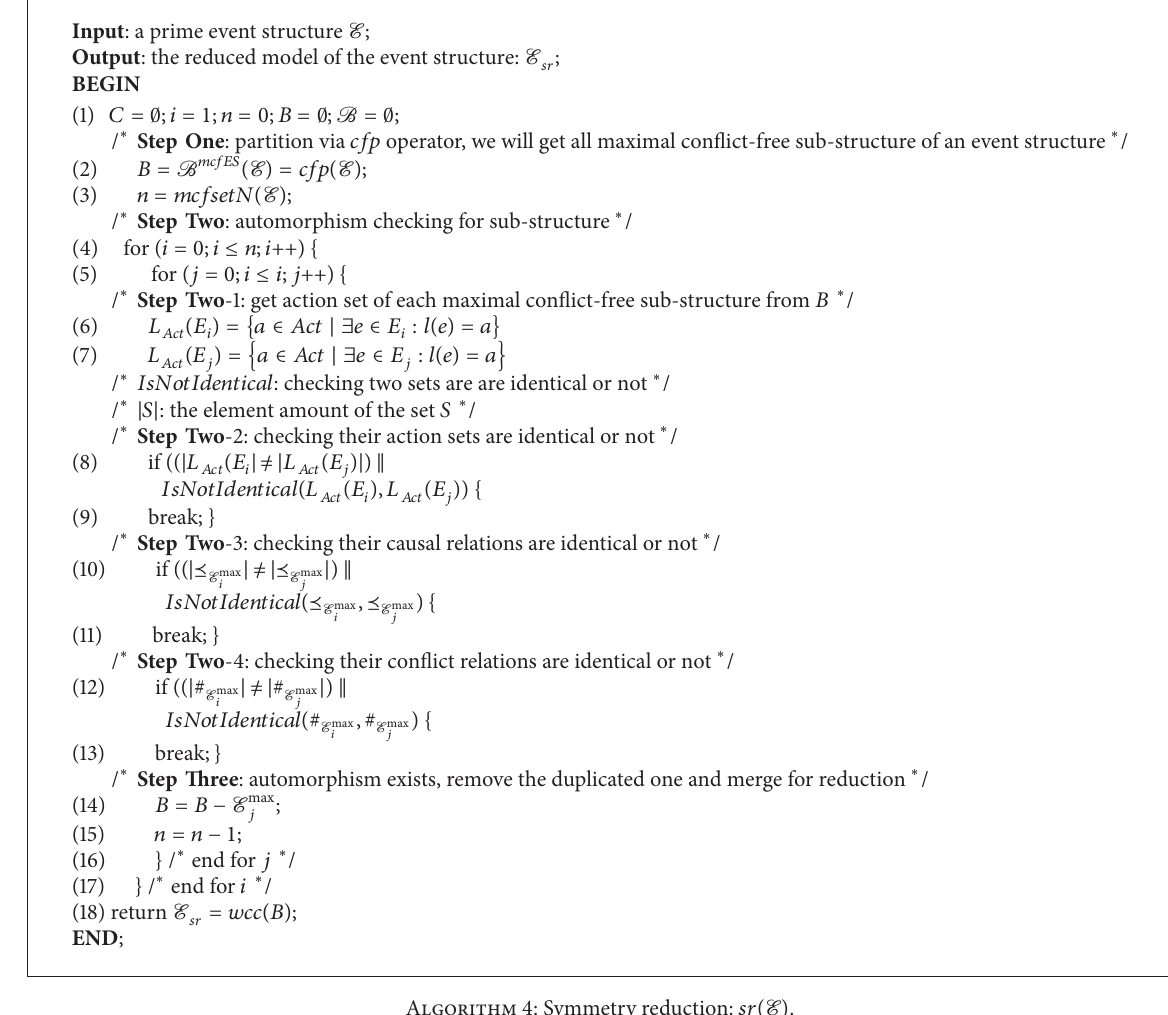
Algorithm 4: Symmetry reduction: 𝑠𝑟( E ) .